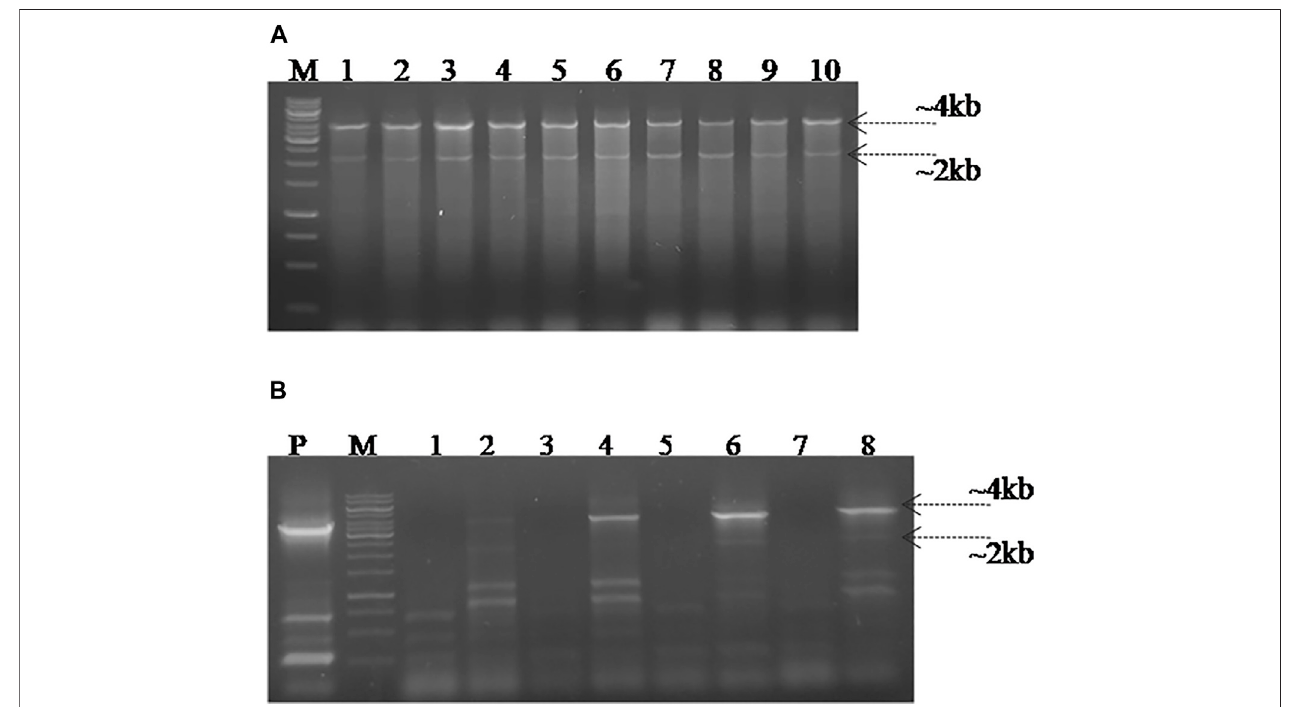
FIGURE 4 | Screening for SpvB deletion in SG18 cells co-transformed with pCas9_g and pCasSA_g plasmids in combination with the DNA editing template carrying vector. (A) All the pCas9-g transformed SG18 colonies screened showed a partial deletion of the SpvB gene, while (B) pCasSA-g transformed SG18 cells showed apartial deletion ofthe SpvB gene in40%oftotal cells screened.Lanes 1 – 10are thecolonies electroporatedwith correspondingvectors, Lane P;largevirulent plasmids isolated from SG18 cells were used as positive control, showing ampli fi cation of the SpvB gene (4 kb) through screening